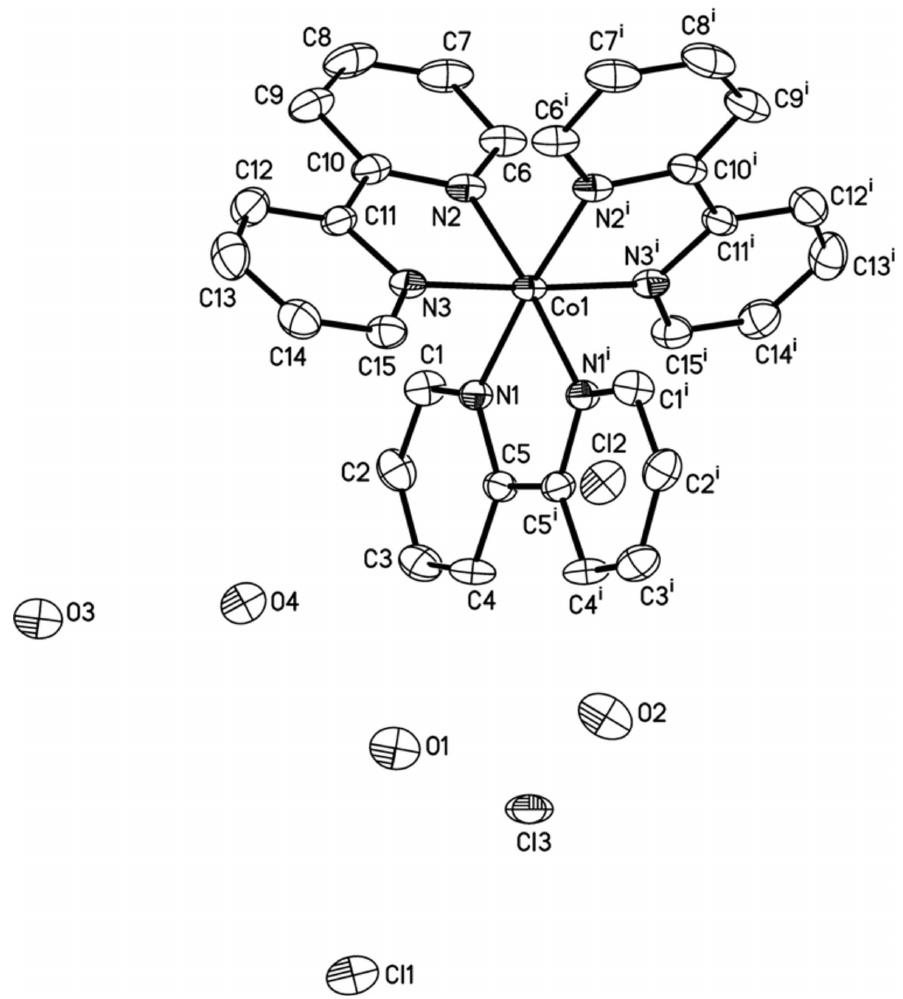
Figure 1 ORTEP view of the title compound. The dispalcement ellipsoids are drawn at 40% probability level. [Symmetry code: (i) - x + 1/2, y , - z +